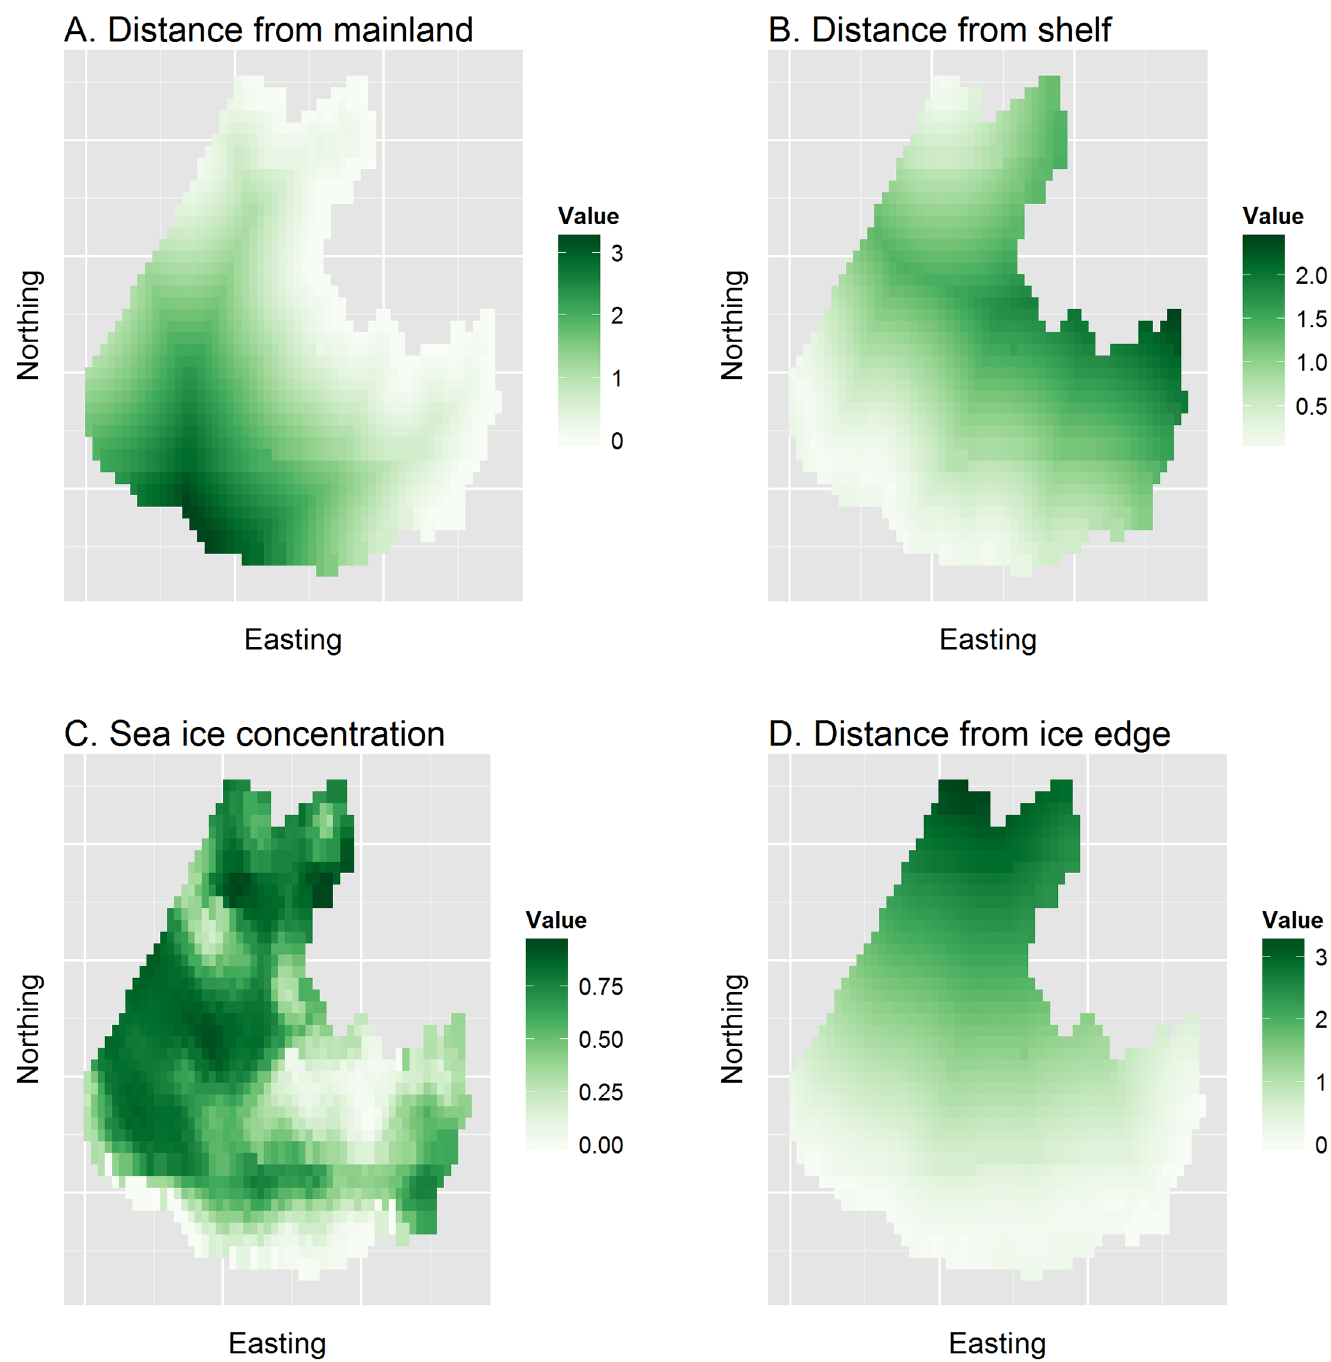
Fig 3. Assembled covariates used to help explain and predict ribbon seal relative abundance in the eastern Bering Sea. Covariates include distance from mainland ( dist_mainland ), distance from 1000m depth contour ( dist_shelf ), average remotely sensed sea ice concentration while surveys were being conducted ( ice_conc ), and distance from the southern sea ice edge ( dist_edge ). All covariates except ice concentration were standardized to have a mean of 1.0 prior to plotting and analysis.